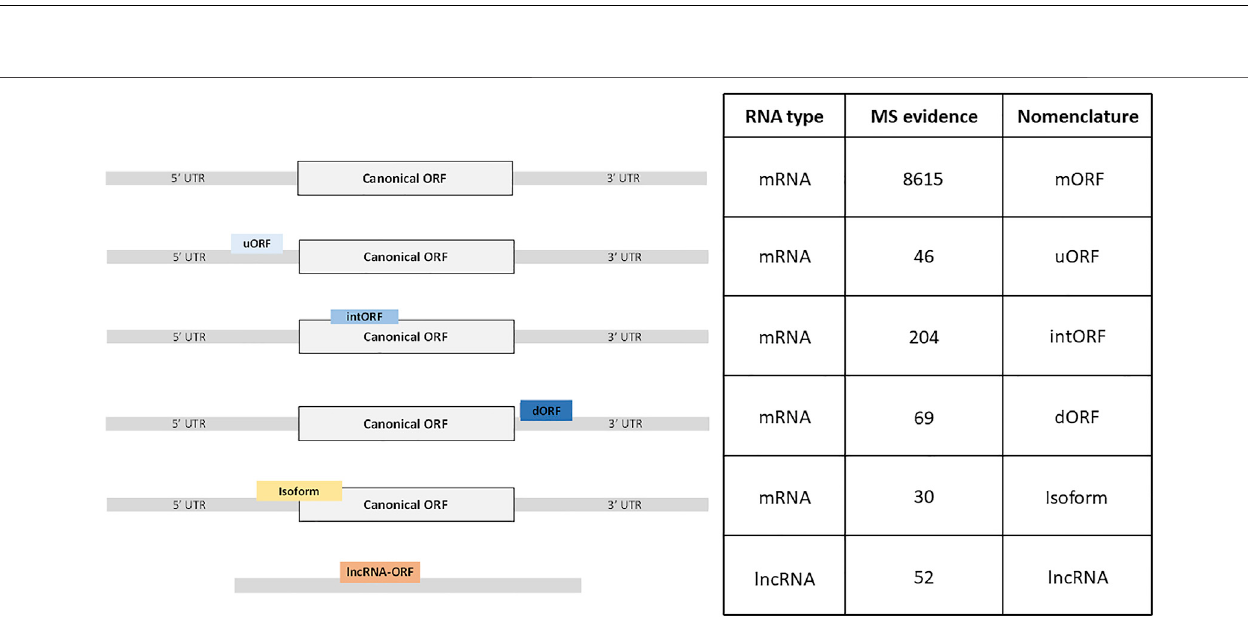
FIGURE 2 | Different classes of ORFs produce yet non-annotated alternative proteins. Hundreds of alternative proteins are produced from ORFs from novel isoforms, ORFs located in the 5 ′ UTR (uORF), coding sequence (intORF) or 3 ′ UTR (dORF)of mRNAs, or from non-annotated ORFs on long non – coding RNAs (lncRNA). The nomenclature of the different classes of ORFs was adapted from Mudge et al.